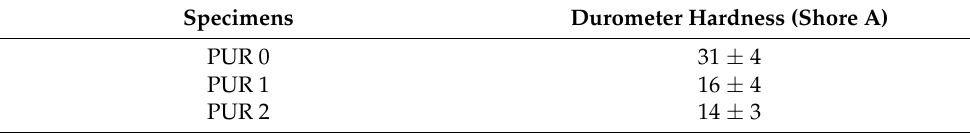
Table 3. Hardness of PURs.